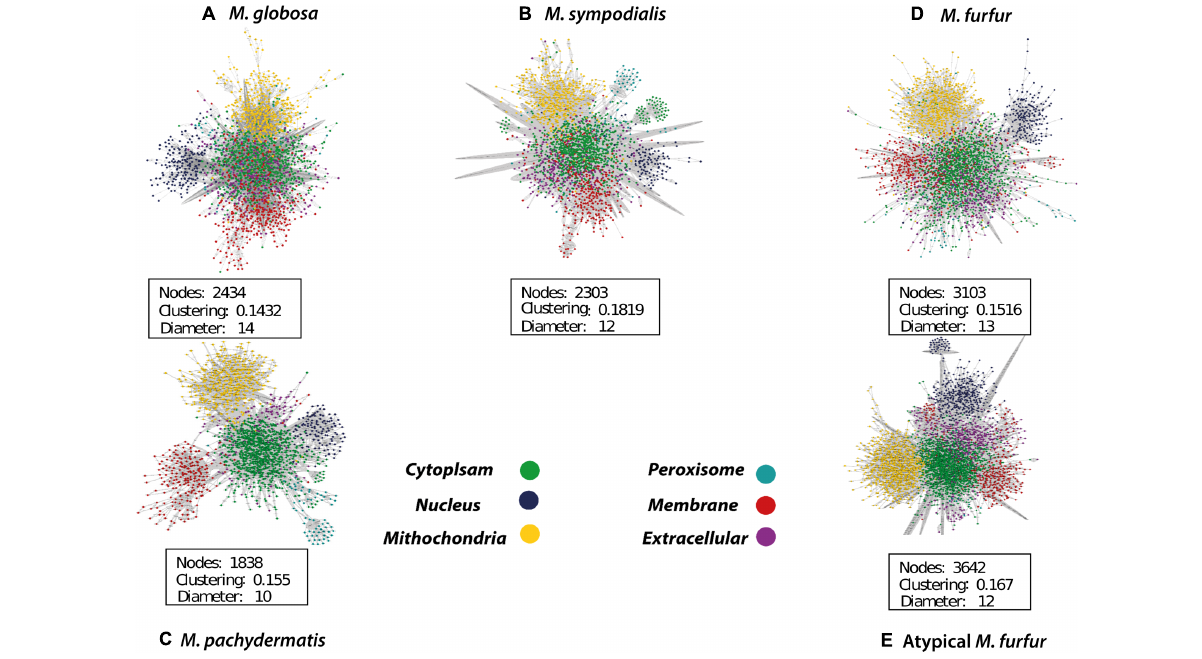
FIGURE 6 | Compartmentalized metabolic network of Malassezia globosa (A) , Malassezia sympodialis (B) , Malassezia pachydermatis (C) , Malassezia furfur (D) , and atypical Malassezia furfur (E) visualized in Cytoscape (Shannon et al., 2003).